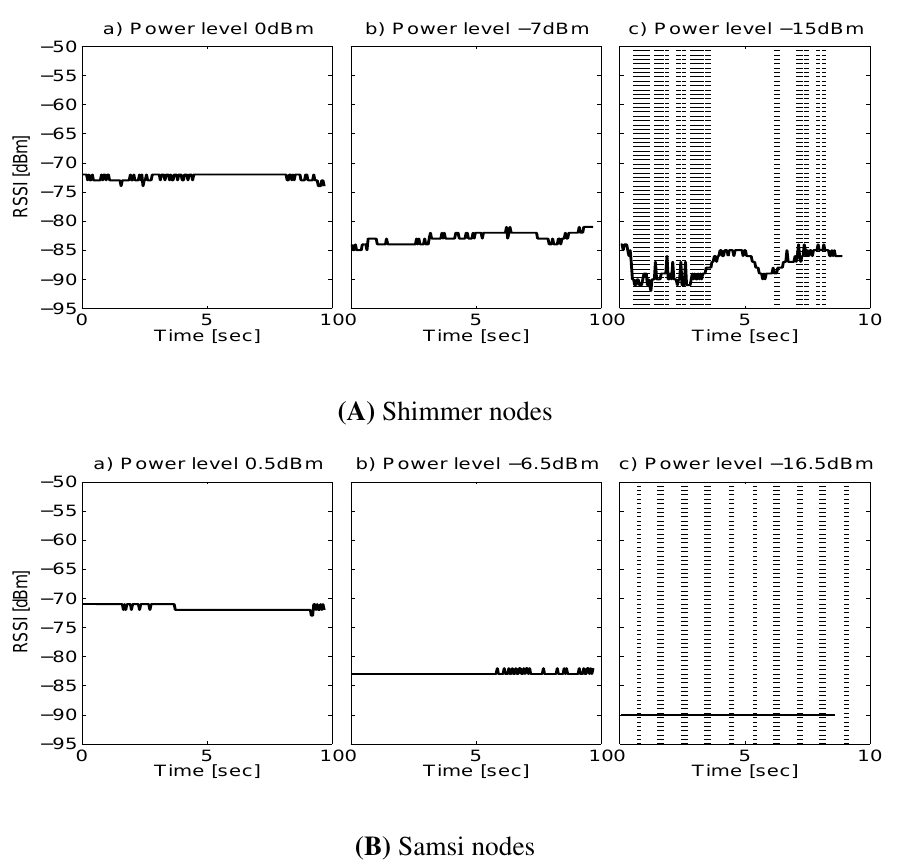
Figure 9. Power variations for Subject 1